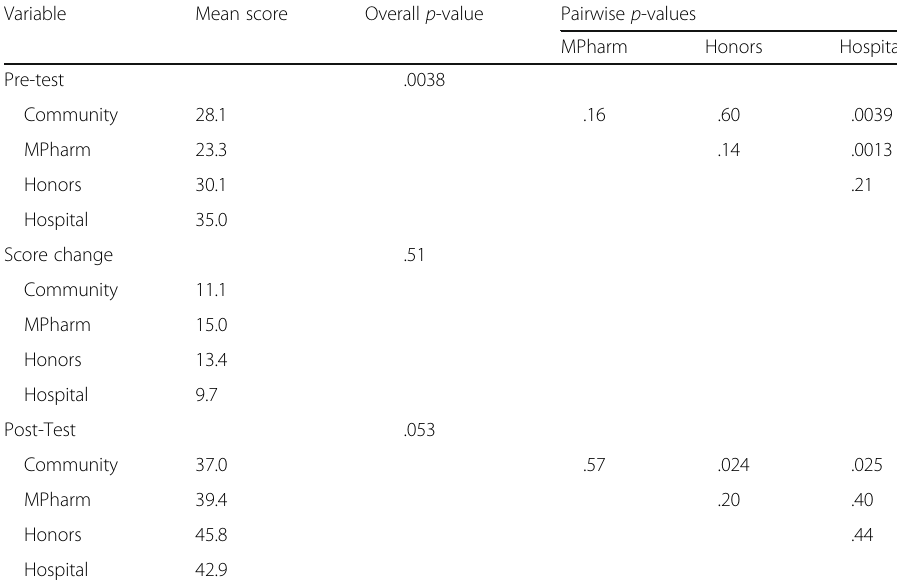
Table 3 Analysis of knowledge and skills test scores between participant type (results obtained from the General Linear Model)